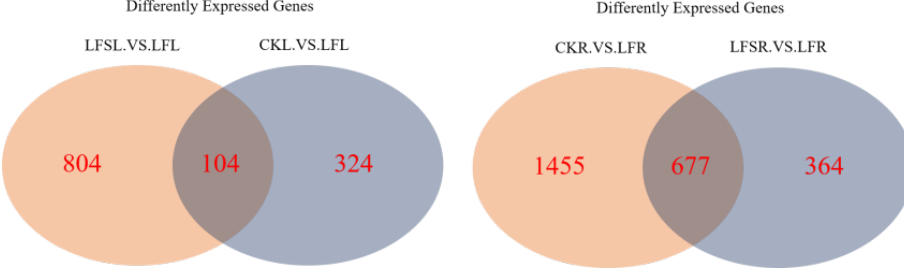
Figure 3. Venn diagram of significantly differentially expressed genes in different treatment compar- isons. LFSL. vs. LFL, Low Fe+ Spd_Leaf sample vs. Low Fe_Leaf sample; CKL. vs. LFL, Control_Leaf sample vs. Low Fe_Leaf sample; CKR.VS.LFR, Control_Root sample vs. Low Fe_Root sample; LFSR. vs. LFR, Low Fe+ Spd_Root sample vs. Low Fe_Root